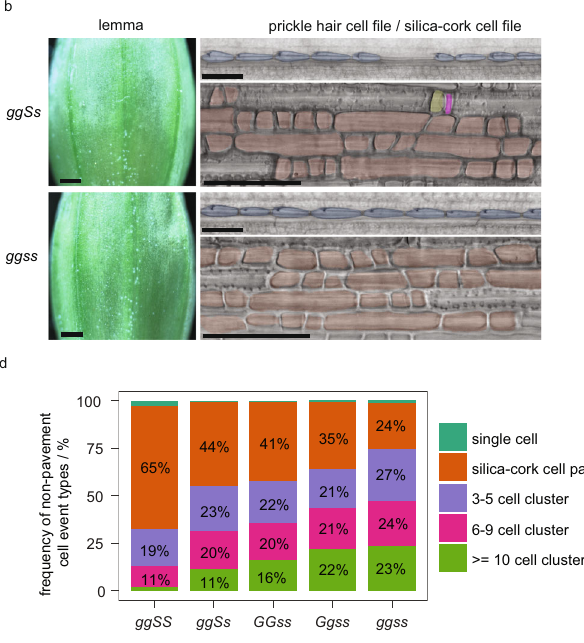
Fig. 3 | Phenotypic analysis of cer-g . 10 and cer-s.31 allele combinations. a Phenotypic severity of cer-g.10 / cer-g.10 +/+, cer-g.10 / cer-g.10 cer-s.31 /+, +/+ cer- s.31 / cer-s.31 , cer-g.10 / cer-g.10 cer-s .31/+ and cer-g.10 / cer-g.10 cer-s.31 / cer-s.31 . Dif- ferent letters indicate a signi fi cant difference ( p =0.05; 1 one-way ANOVAs with square-root transformation and Tukey ’ s HSD multiple comparison; 2 Dunn ’ s test following a Kruskal-Wallis test; 3 one-way ANOVAs and Tukey ’ s HSD multiple com- parison). b Lemma wax deposition (scale bars=1mm) and prickle hair cell (blue; scale bars=100 µ m) and silica (pink) -cork (yellow) cell patterning (scale bars=50 µ m) of cer-g.10 / cer-g.10 cer-s .31/+ and cer-g.10 / cer-g.10 cer-s.31 / cer-s.31 . Non-pavement cells with less de fi ned silica – cork identity are coloured orange. N =8